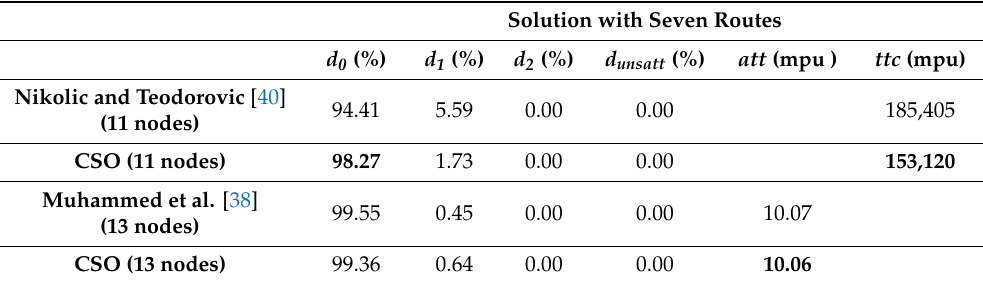
Table 11. Comparative results for the best seven-route solutions for Mandl’s network.